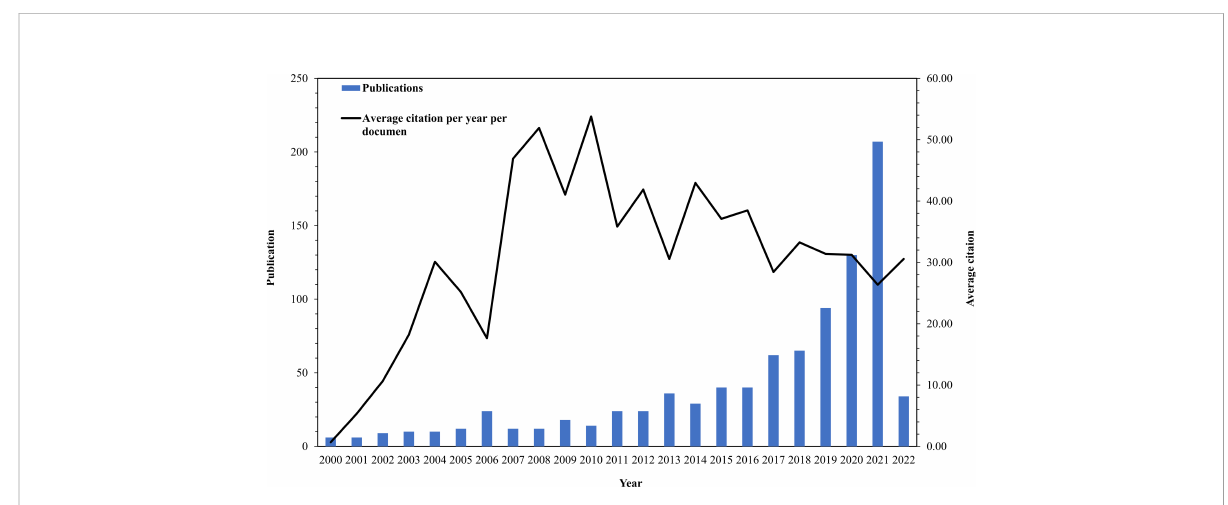
FIGURE 2 Global trend of publications and average citation on arti fi cial intelligence research in esophageal carcinoma